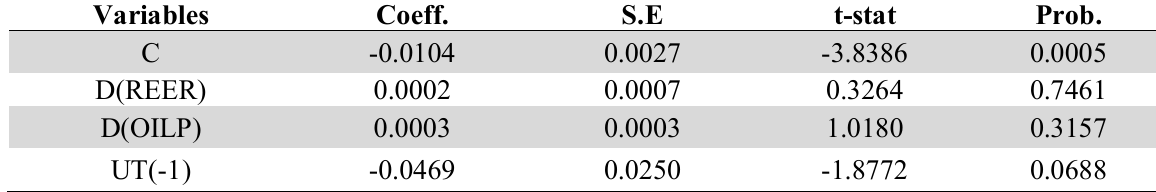
The results of cointegration and Error Correction Mechanism